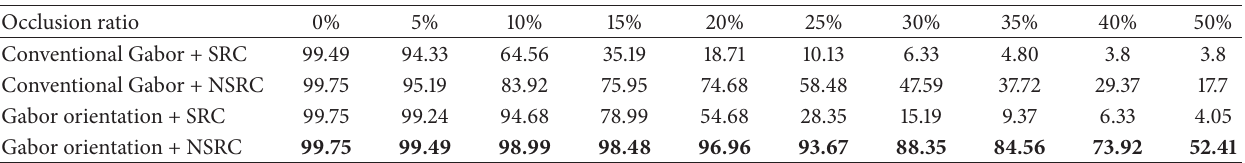
classification algorithm achieves better recognition